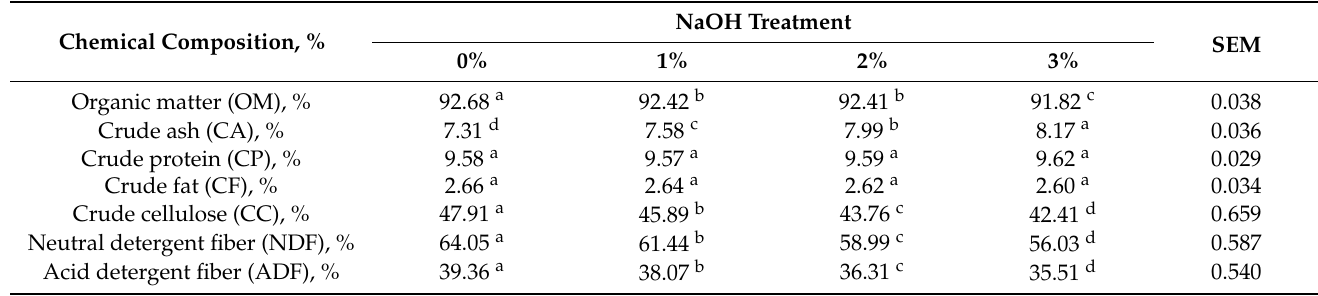
Table 1. Effects of NaOH treatment on the chemical composition of reed